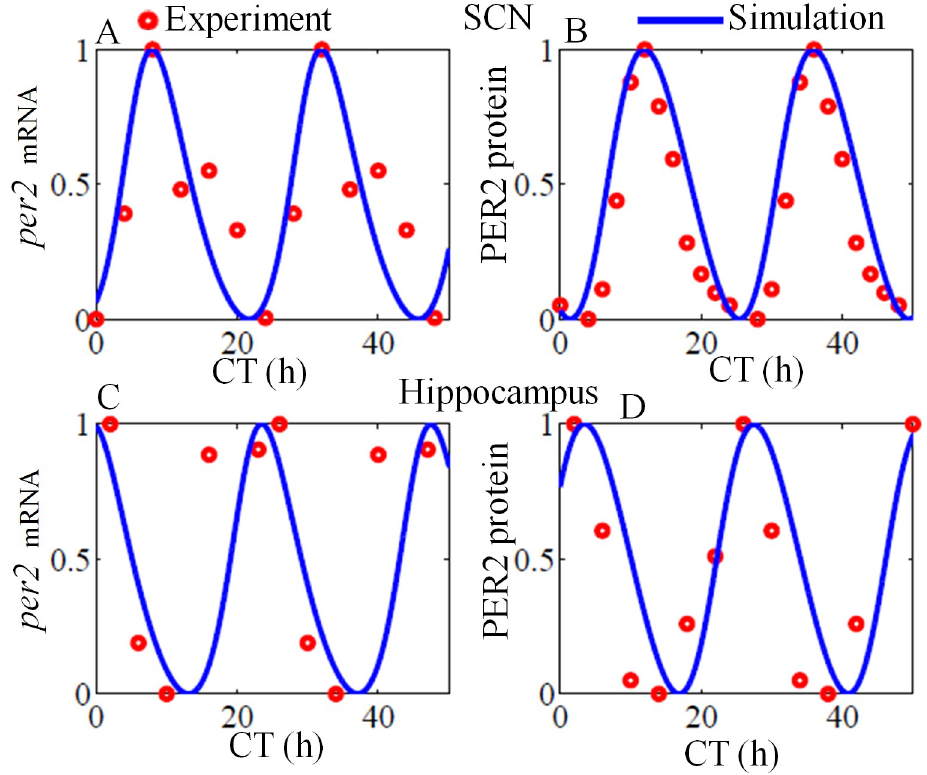
Fig 5. Free running oscillation at SCN and hippocampus under constant darkness condition. Blue curves are from simulation, and red circles are the experimental data points. Simulated per2 mRNA and protein at SCN (A, C) and hippocampus shows antiphase oscillations, which is good agreement with the experimental observations. Simulation results were obtained by integrating the model equations given in materials and method section with I comparison, the individual time series were normalized to [0, 1]. Experimental data points of per2 mRNA and protein at SCN are extracted from [60] and for hippocampus, the data is extracted from [10].